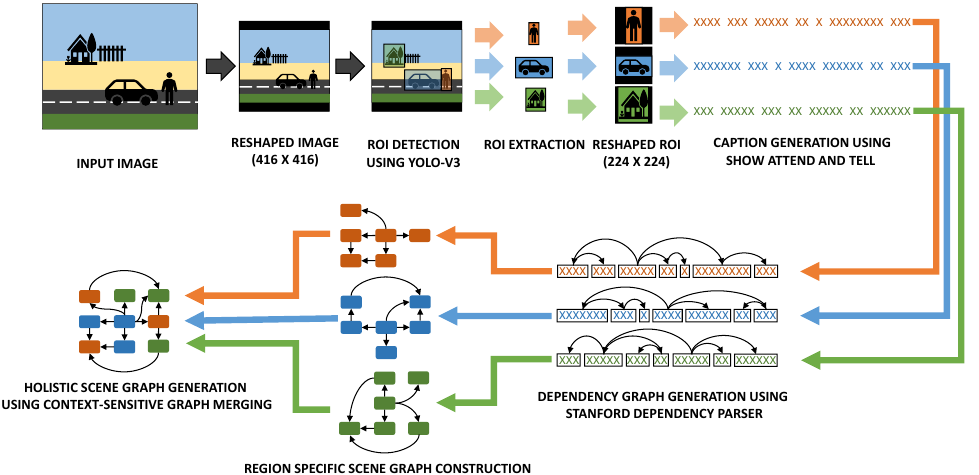
Figure 2. Block diagram of the proposed